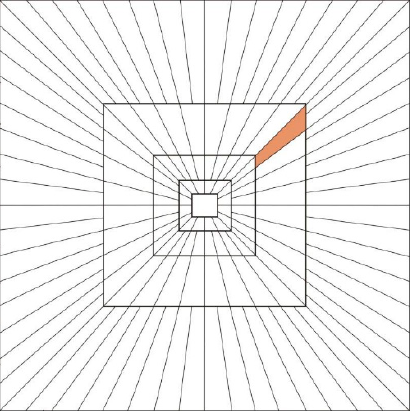
Figure 1. Frequency-Domain Base of Curvelet Transform.